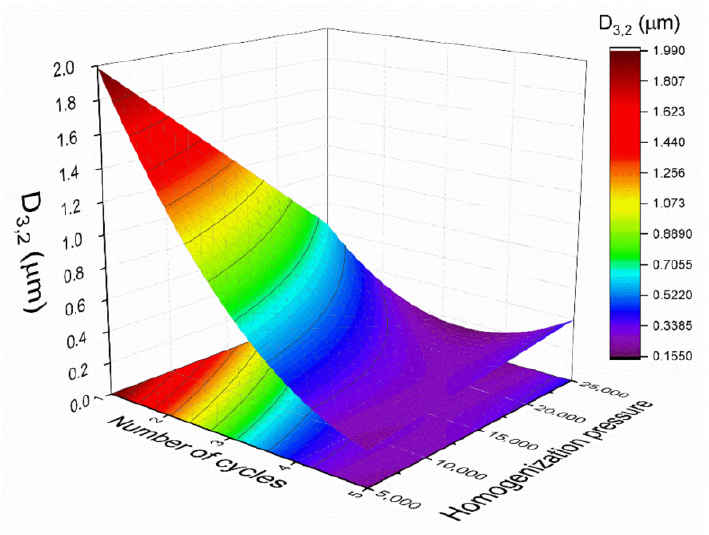
Figure 3. Response surface 3D plot of Sauter mean diameter (D 3,2 ) as a function of the number of cycles and the homogenization